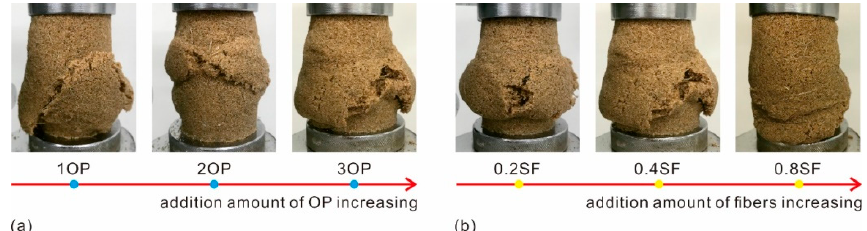
Figure 14. The failure pattern of OPSFRS with ( a ) 0.4SF and different OP contents. ( b ) 3OP and different SF contents.